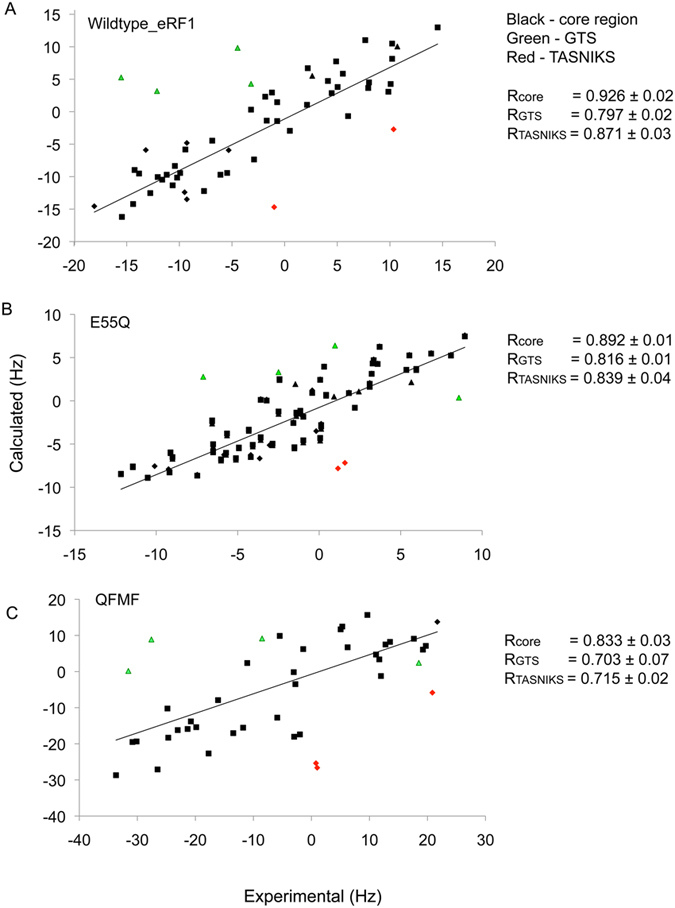
RDC experiments of wild-type and mutant eRF1 in Pf1 alignment media.Experimental and calculated residual dipolar coupling (RDC) for wild-type eRF1 and their correlation factors with respect to the full-length (A) wild-type eRF1 crystal structure without the GTS and NIKS regions (black), with the GTS loop included (green) and with the NIKS region included (red) using PALES. The same as observed for (B) E55Q and (C) Q122FM(Y)F126. The correlation coefficient for each protein is listed as RCORE, RGTS or RNIKS.